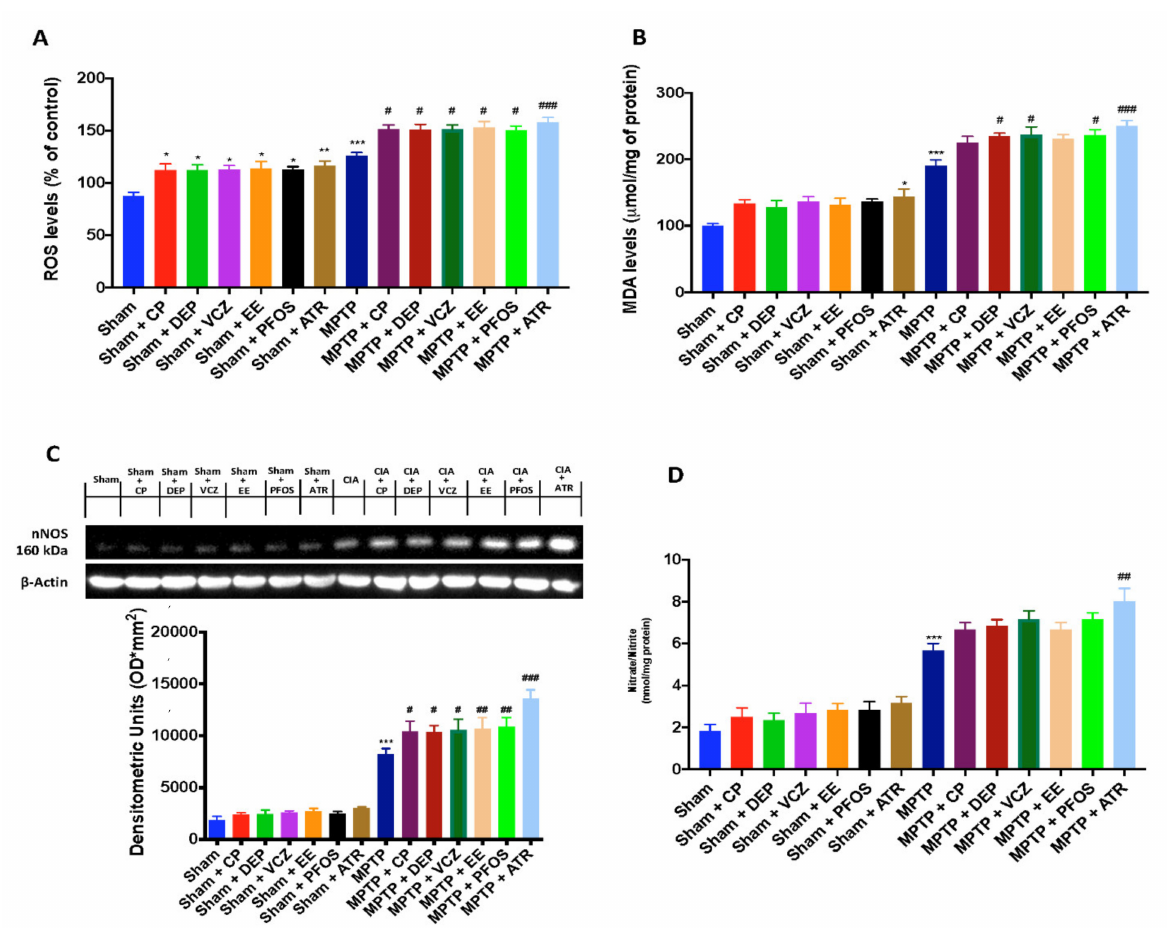
Figure 6. Levels of ROS ( A ) and MDA ( B ). Western blots and densitometric analysis of nNOS ( C ). Nitrate/nitrite levels ( D ). A demonstrative blot of lysates with a densitometric analysis for all animals is shown. Data are expressed as the mean ± SEM of N = 6 mice/group. * p <0.05 vs. sham; ** p < 0.01 vs. sham; *** p < 0.001 vs. sham; # p < 0.05 vs. MPTP; ## p < 0.01 vs. MPTP; ### p < 0.001 vs.